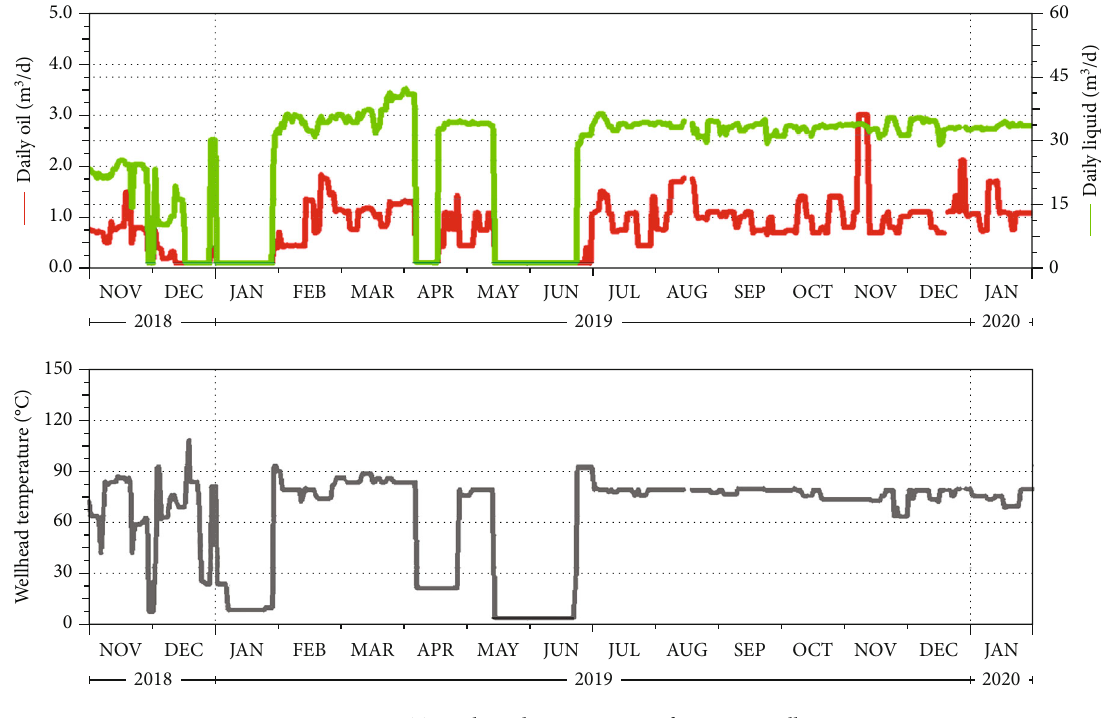
Figure 13: Typical production curves of a type II well.